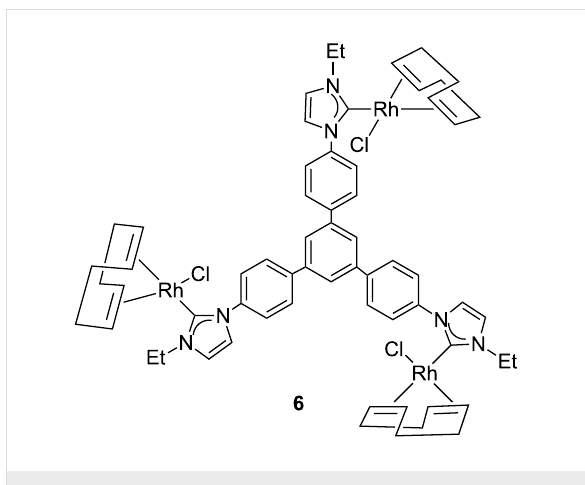
Scheme 4: Schematic representation of complex 6